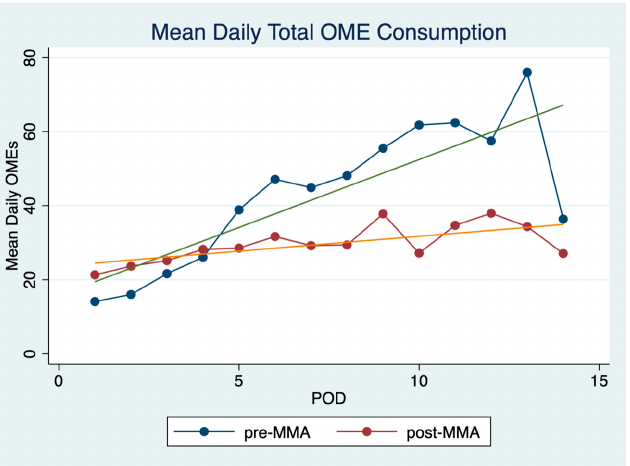
Figure 3. Mean daily OME consumption. Mean daily OME (oral morphine equivalents) consumption over the first 14 postoperative days.